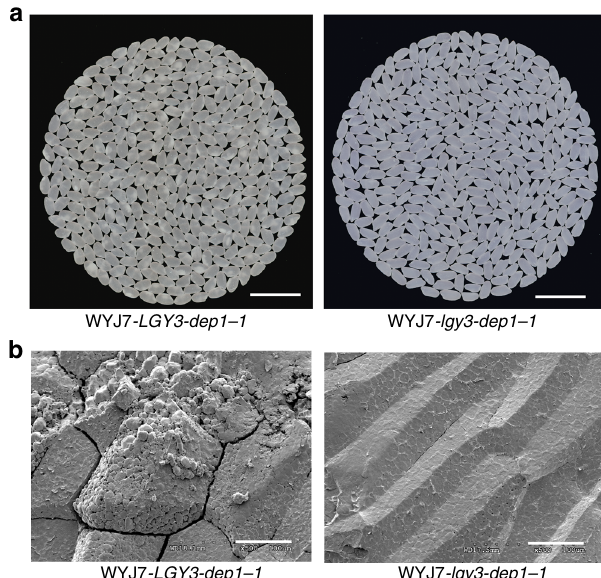
Fig. 2 Introduction of the lgy3 allele into the high-yielding variety results in the improvement of rice grain quality. a Comparisons of grain chalkiness and endosperm transparency between the WYJ7- LGY3-dep1-1 and WYJ7- lgy3-dep1-1 plants. Scale bar: 15 mm. b Scanning electron microscopy images of the transverse sections of starch granule from the WYJ7- LGY3- dep1-1 and WYJ7- lgy3-dep1-1 plants. Scale bar: 50 µ m. The endosperm